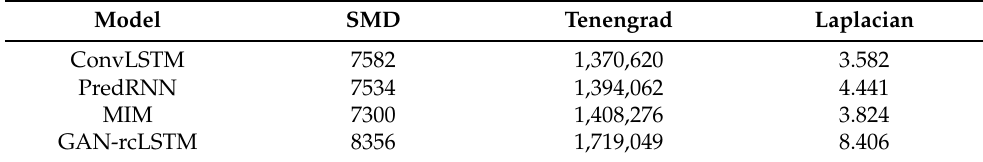
Table 5. Quantitative sharpness metrics of prediction results for different methods at a lead of 30 frames.